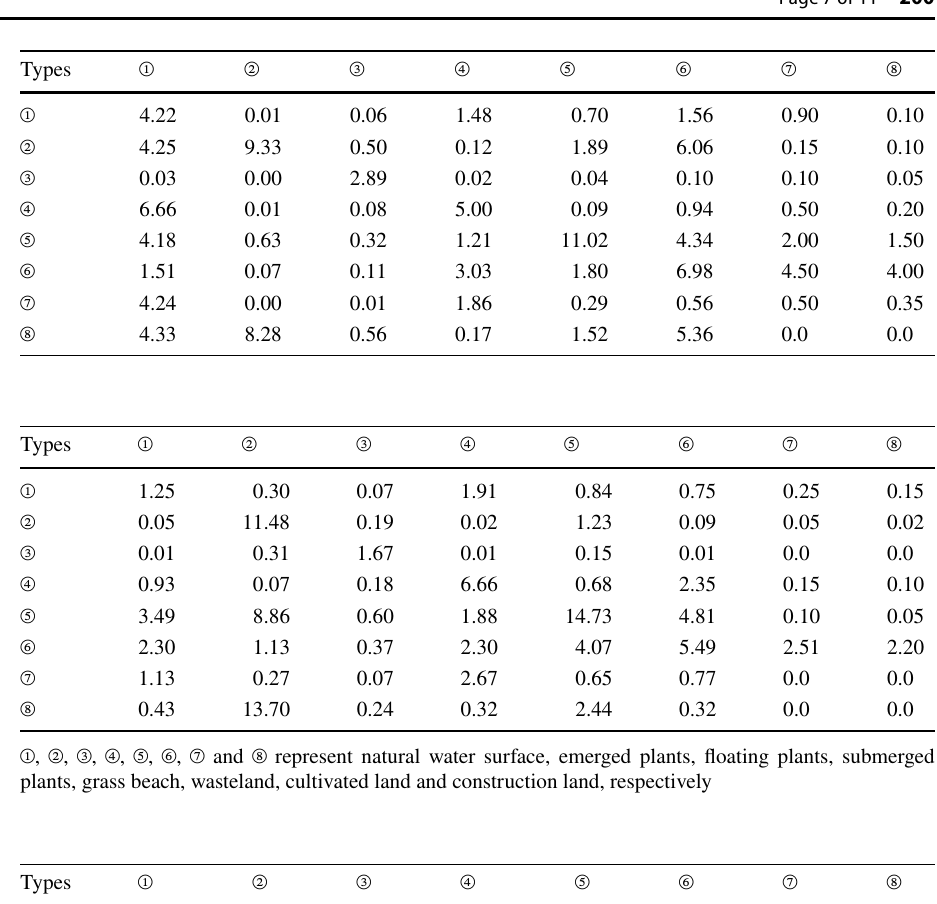
transfer from 2020 to the future (km 2